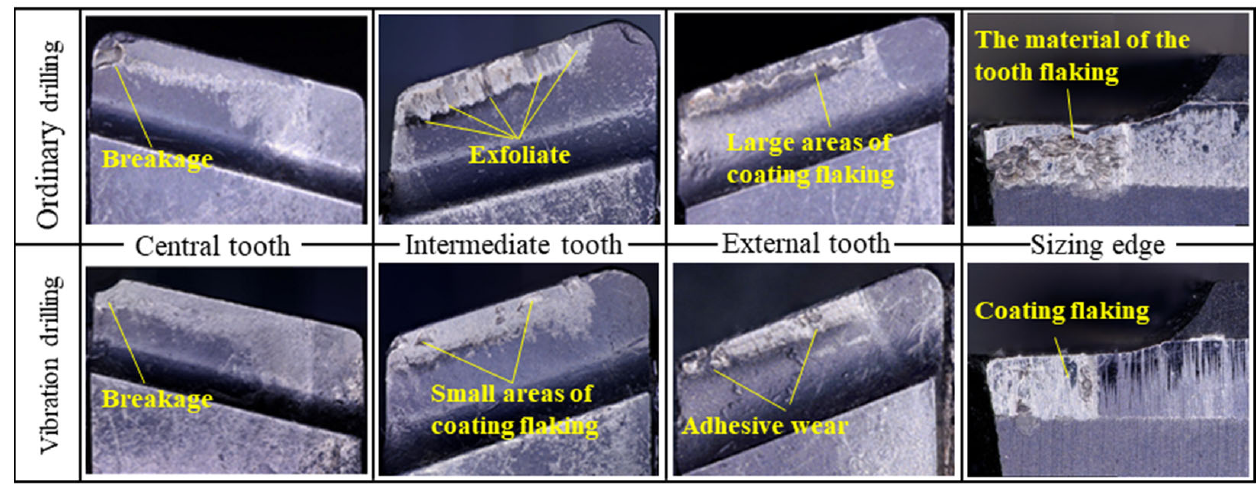
Figure 9. Wear pattern of the sizing edge and rake face of each tooth by different drilling methods.